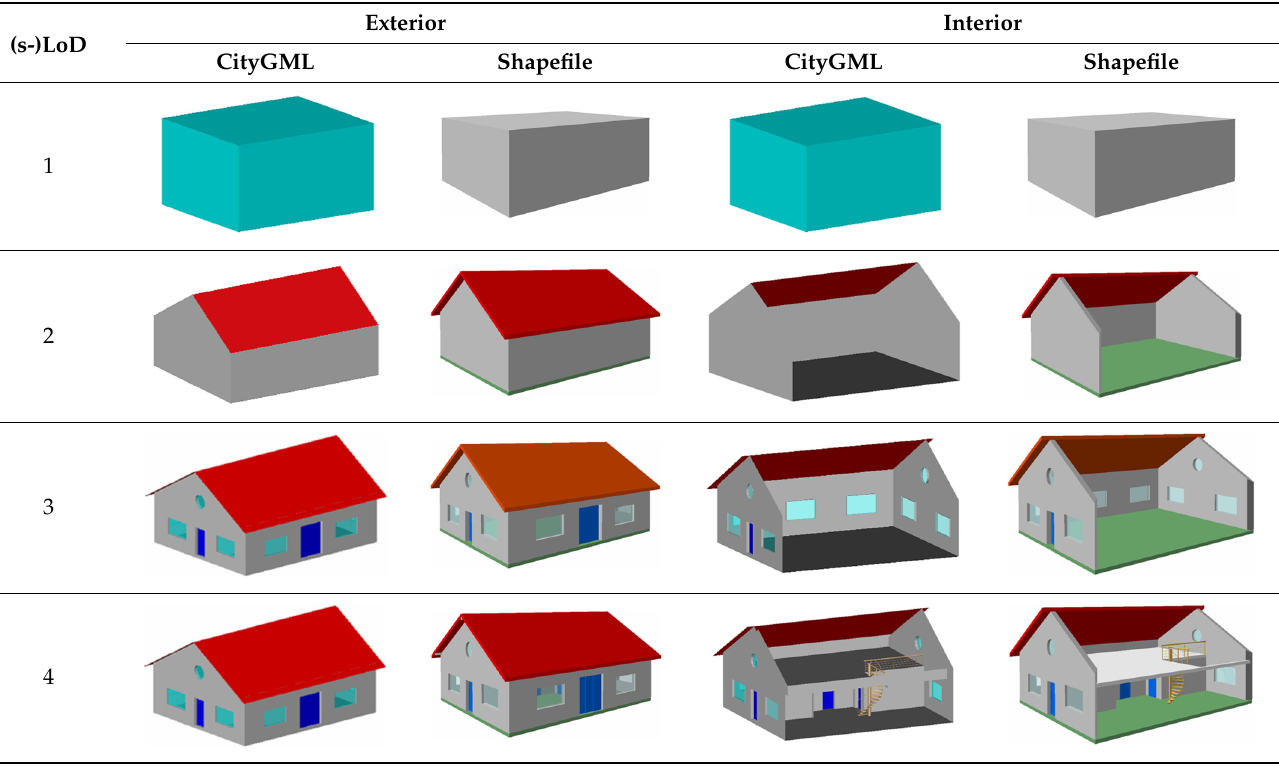
Table 13. File size of the shapefile and CityGML model of house in each (s-)LoD.